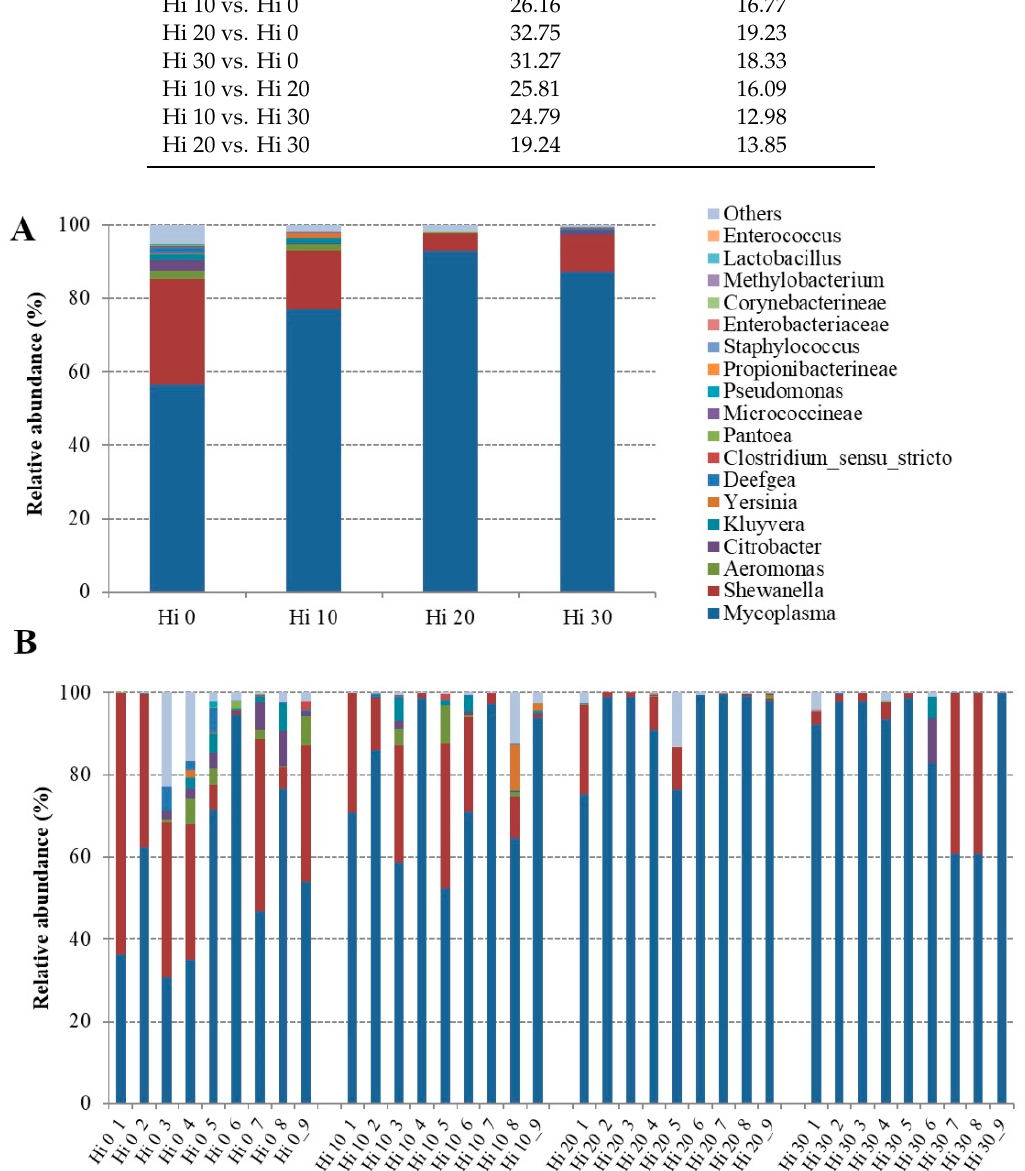
Figure 4. Relative abundance (%) of the overall most prevalent bacterial genera in each dietary groups ( A ) and individual fish ( B ). In the figure, all taxa with an overall abundance of ≥ 0.01% were reported. Table 2. Number of reads per sample assigned to OTUs and alpha diversity metrics values (normalized at the lowest sample size: 17,800 sequences) of gut microbial community of rainbow trout